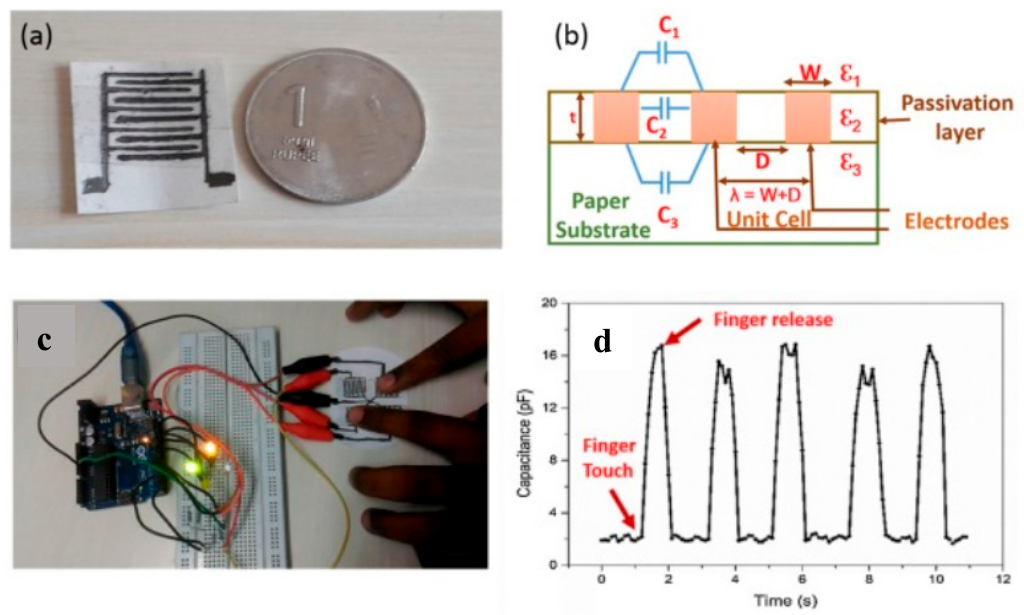
Figure 36. ( a ) Picture of the interdigitated capacitive sensor, with tracks made remarkably simply with a graphite pencil on paper. ( b ) Electrical details of the sensor and its capacitances. ( c ) Photograph of the functioning touchpad. ( d ) Variation in capacitance of a single sensor upon finger contact. Adapted from [159] with permission. Copyright 2017 from Elsevier.